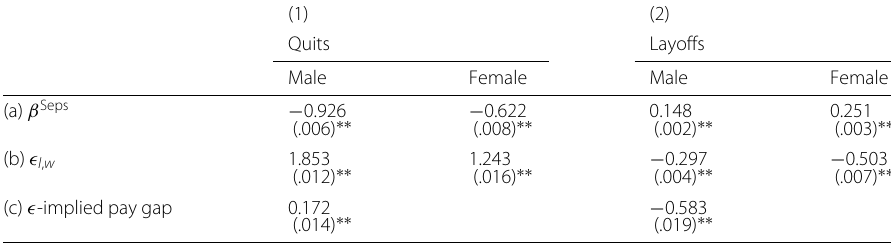
Table 2 Wage elasticity of voluntary vs. involuntary